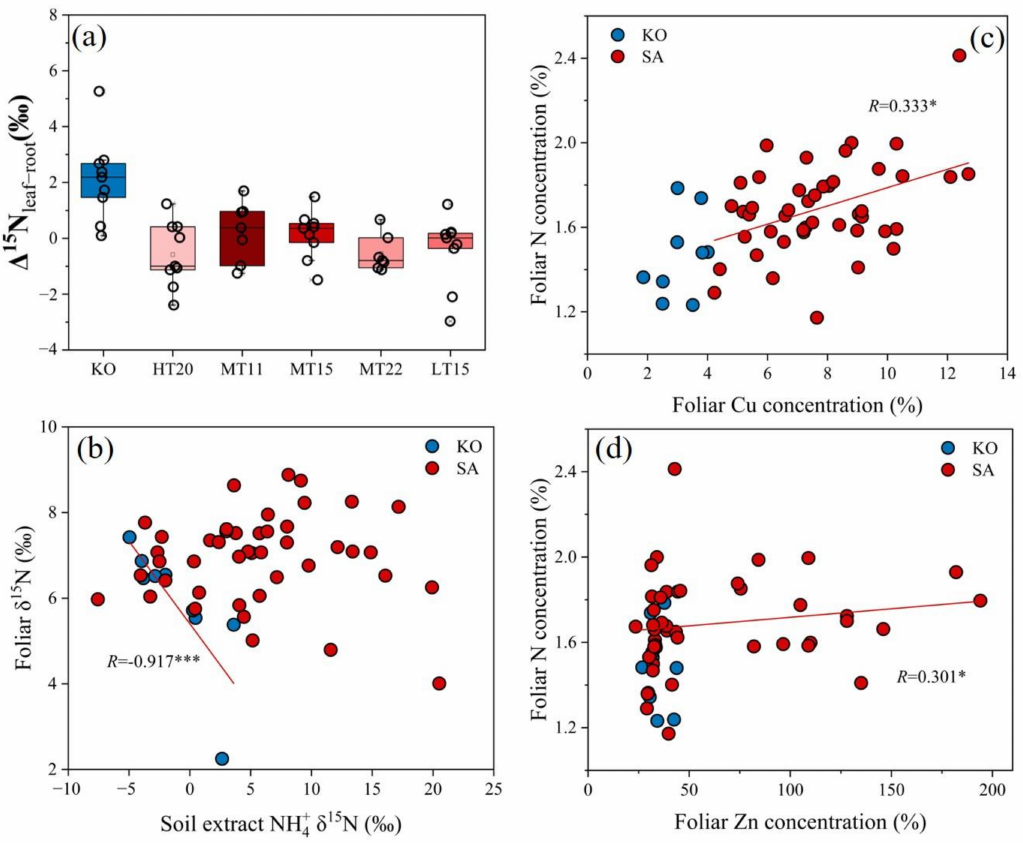
Figure 5. ( a ) ∆ 15 N leaf–root values of the Qi’ao mangrove forest. ( b ) The relationship between fo- liar δ 15 N and soil-extracted NH 4+ δ 15 N. ( c , d ) Relationship between foliar N and foliar Cu (or Zn) concentrations. KO: Kandelia obovate ; SA: Sonneratia apetala ; *** means p < 0.001; * means p < 0.05. In addition, the preference of NO 3 − to NH 4+ in KO can also be seen by the negative correlation between foliar δ 15 N and soil-extracted NH 4+ δ 15 N (Figure 5b). Moreover, the relationship between foliar N and heavy metal concentrations provided another line of evidence of the inter-specific differences in N source preferences between KO and SA. Since specific NO 3 − transport proteins and NO 3 − reductase enzymes could both be interfered with by excess zinc (Zn) and copper (Cu) [57,58], the significantly higher Zn and Cu concentrations, as well as the positive correlations of foliar N and Cu (or Zn) concentrations in SA ( p < 0.05) (Figure 5c,d), also suggested the preference for NH 4+ by A. However, no positive correlation was observed between foliar δ 15 N and soil-extracted NH 4+ δ 15 N for SA, likely due to uncertainties associated with the N uptake at depths beyond 10 cm and the contribution of tidewater NH 4+ . In anoxic mangrove sediments, nitrification rates are low and NH 4 + is the dominant inorganic N species throughout the year. The preference for NO 3 − by KO, as well as inter-specific competition and specific preferences for different N sources, can be an ecosystem-scale strategy to maximize resource use efficiencies and ensure N acquisition by different mangrove plants in N-limited environments